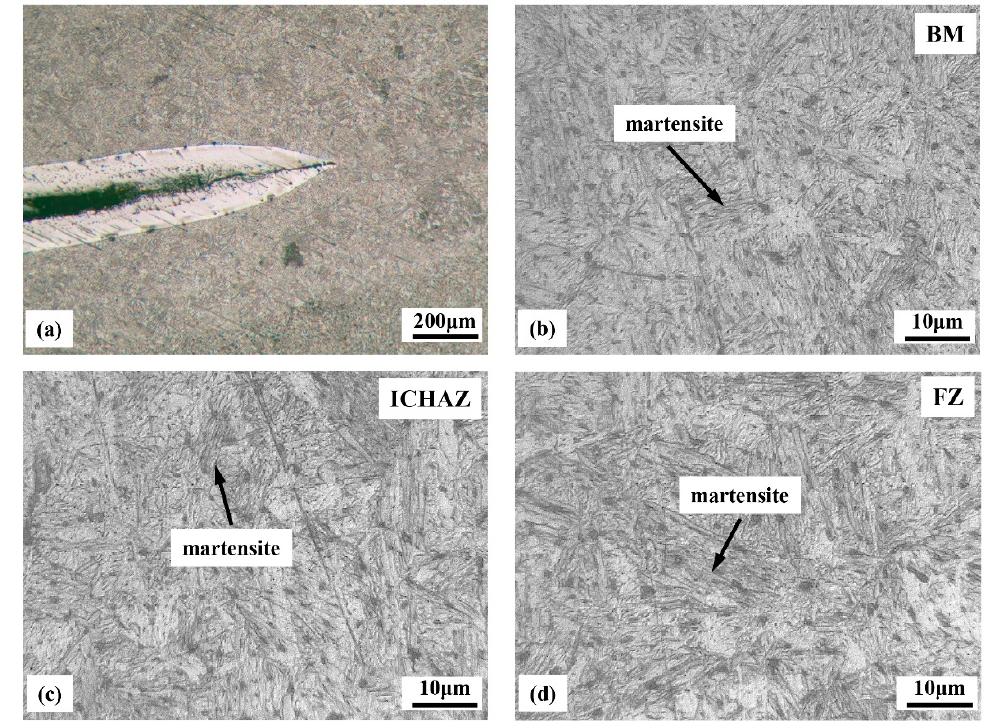
Figure 4. Microstructures of the HT welding spot: ( a ) overview of the welded joint; ( b ) base metal; ( c ) intermediate critical heat-affected zone; ( d ) fusion zone.